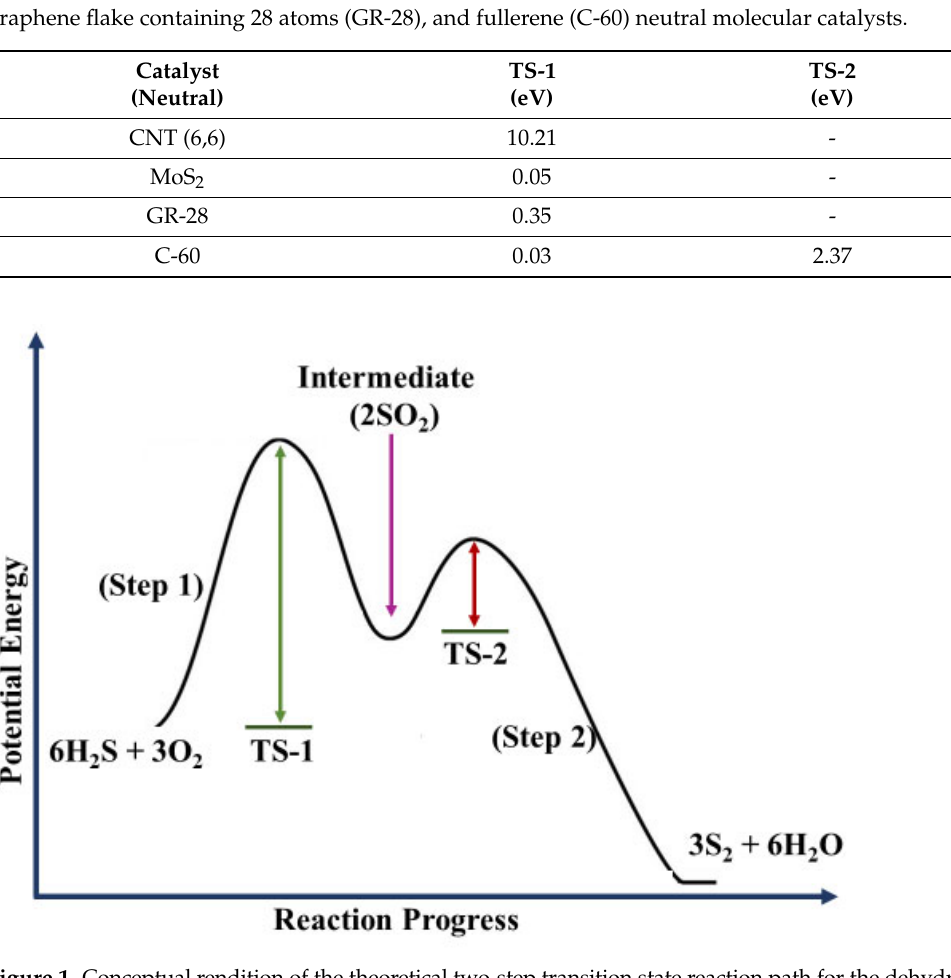
Table 3. Calculated neutral relative initial, transition, and final states in electron-volts (eV) of step 1 and step 2 of the desulfurization for armchair (6,6) carbon nanotube, molybdenum disulfide (MoS 2 ),